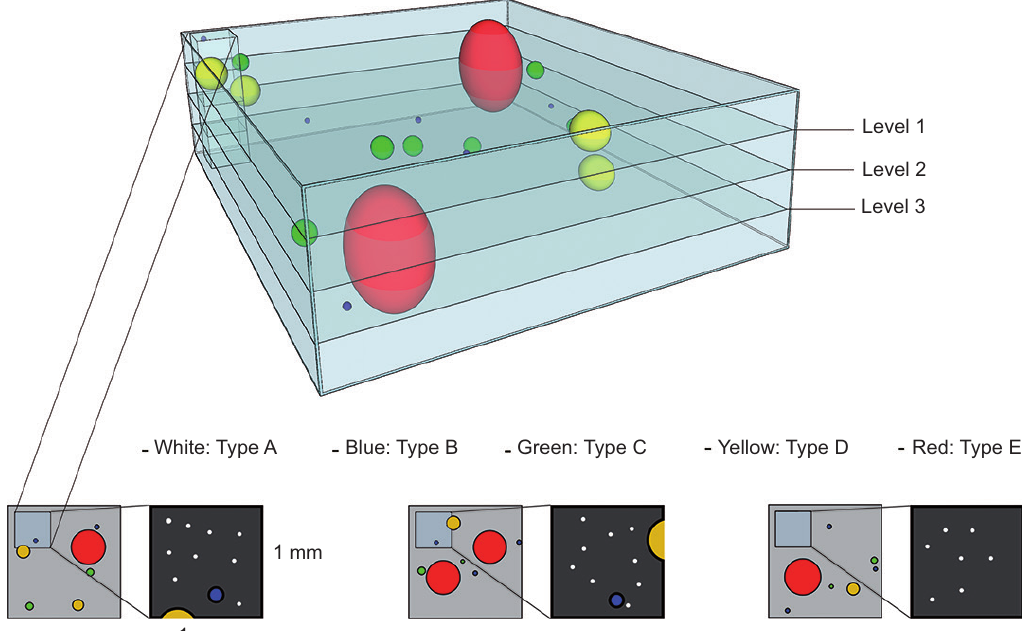
Figure 4: Diagram of VHL kidney block of interest containing pathologic events of different sizes which are displayed in dif- ferent colors. The histologic presentation of different section levels into the block is shown (annotated as “Level 1”, “Level 2”, “Level 3”). Also demonstrated is the micro-BOI column which was represented by a 1mm x 1mm field on each consecutive slide and used for counting type A, B and C events. Consecutive sections through the block allowed for reconstruction of size and shape of each annotated pathologic